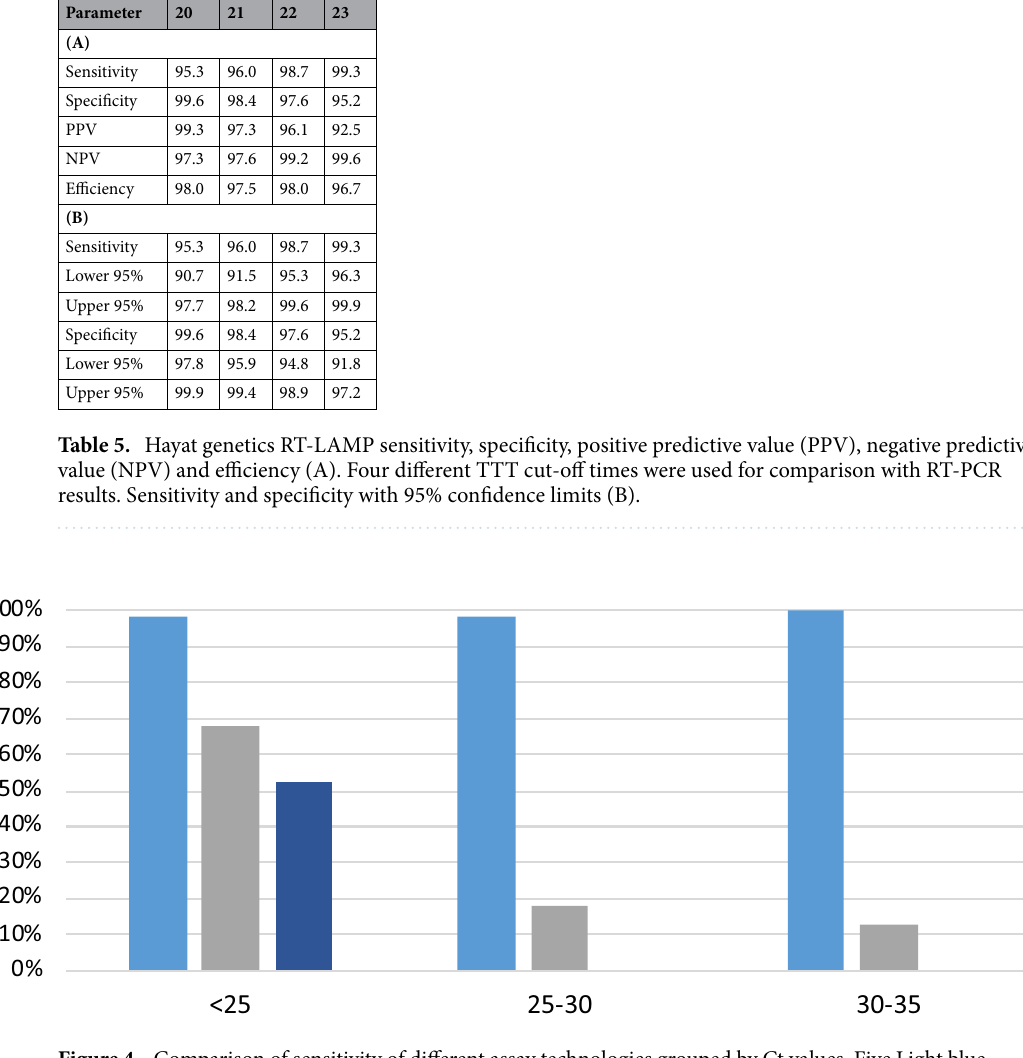
Figure 4. Comparison of sensitivity of different assay technologies grouped by Ct values. Five Light blue— Hayat/Avicena test, grey—direct RT-LAMP, dark blue—RAT/LFD/LFA. Direct LAMP test had initial sensitivity 68% and lost it significantly from Ct 25. RAT/LFD/LFA tests had initial sensitivity 50% and lost it completely from Ct 25 and